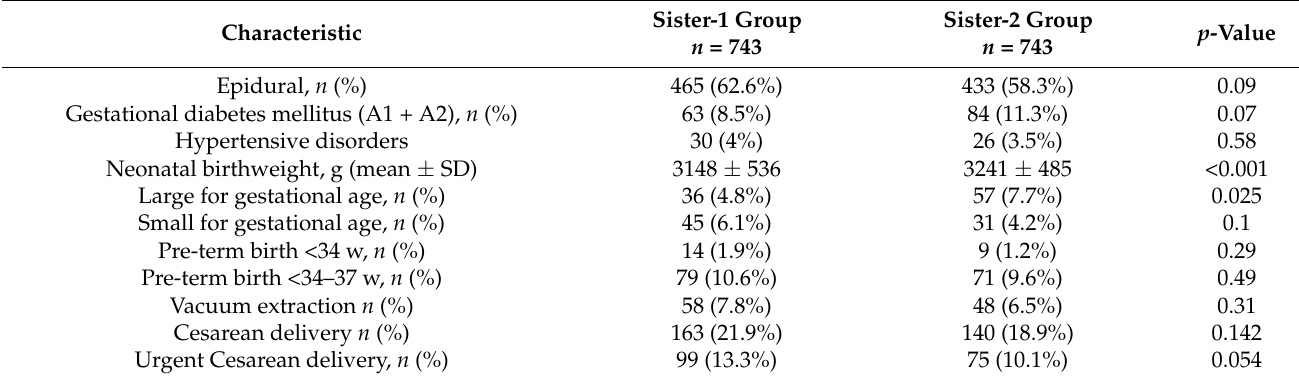
Table 2. Sisters’ obstetrical and neonatal